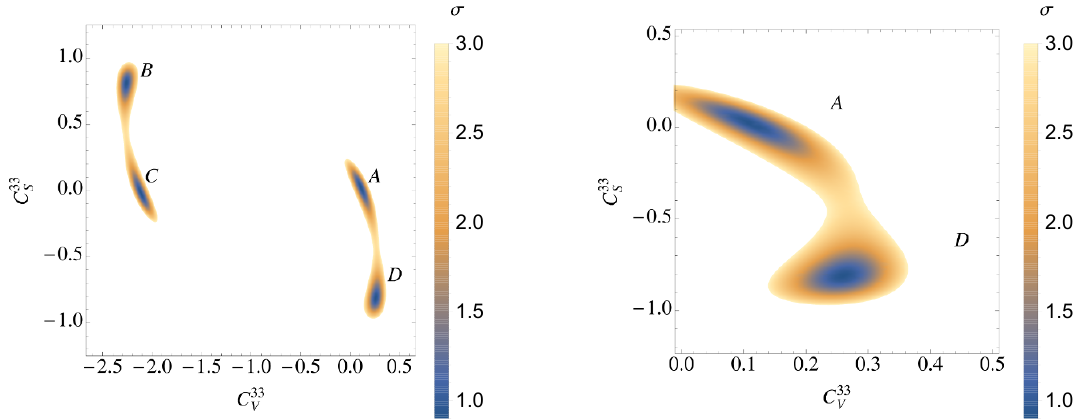
Figure 2. The values for C 33 (cid:3) = 1 TeV. The colors indicate the (cid:27) values of our (cid:12)t. The right plot is zoomed to the area around regions A and D